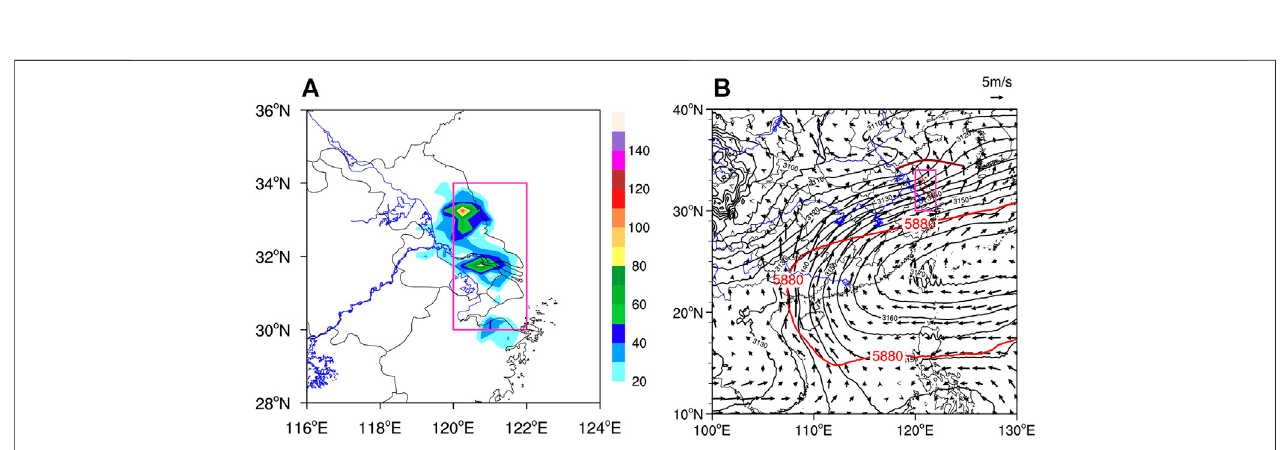
FIGURE 3 | Spatial distributions of accumulated precipitation [ mm , (A) ] at WRWS occurrence moments and associated composites of synoptic-scale circulations (B) . Red (black) solid lines are contours of geopotential height ( gpm ) at 500 hPa (700 hPa). Arrows represent horizontal wind at 850 hPa ( m/s ). Red dots represent the CRA centers of WRWS over coastal areas of YHR (pink box).